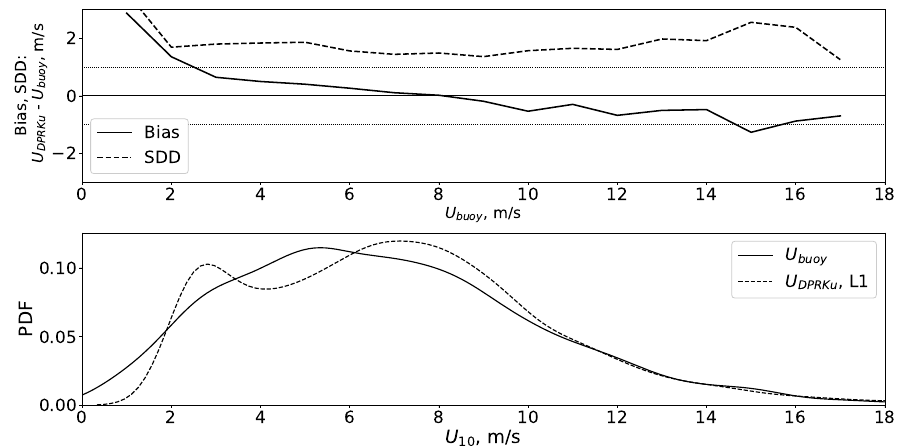
Figure 6. Wind speed difference (bias) and standard deviation of the difference (SDD) between DPR Ku-band radar and NDBC buoys ( top ). Wind speed PDF for DPR and buoy data of L1 array ( bottom ).